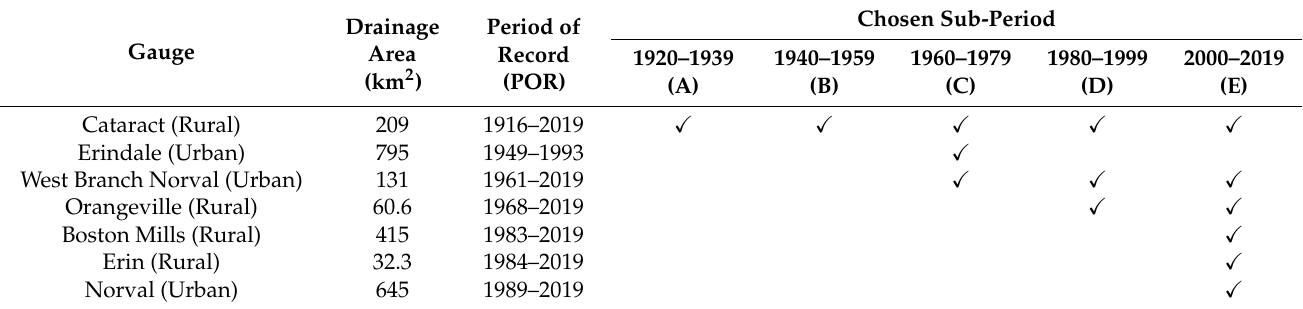
Table 4. Period of record and the sub-period chosen for each of the stream